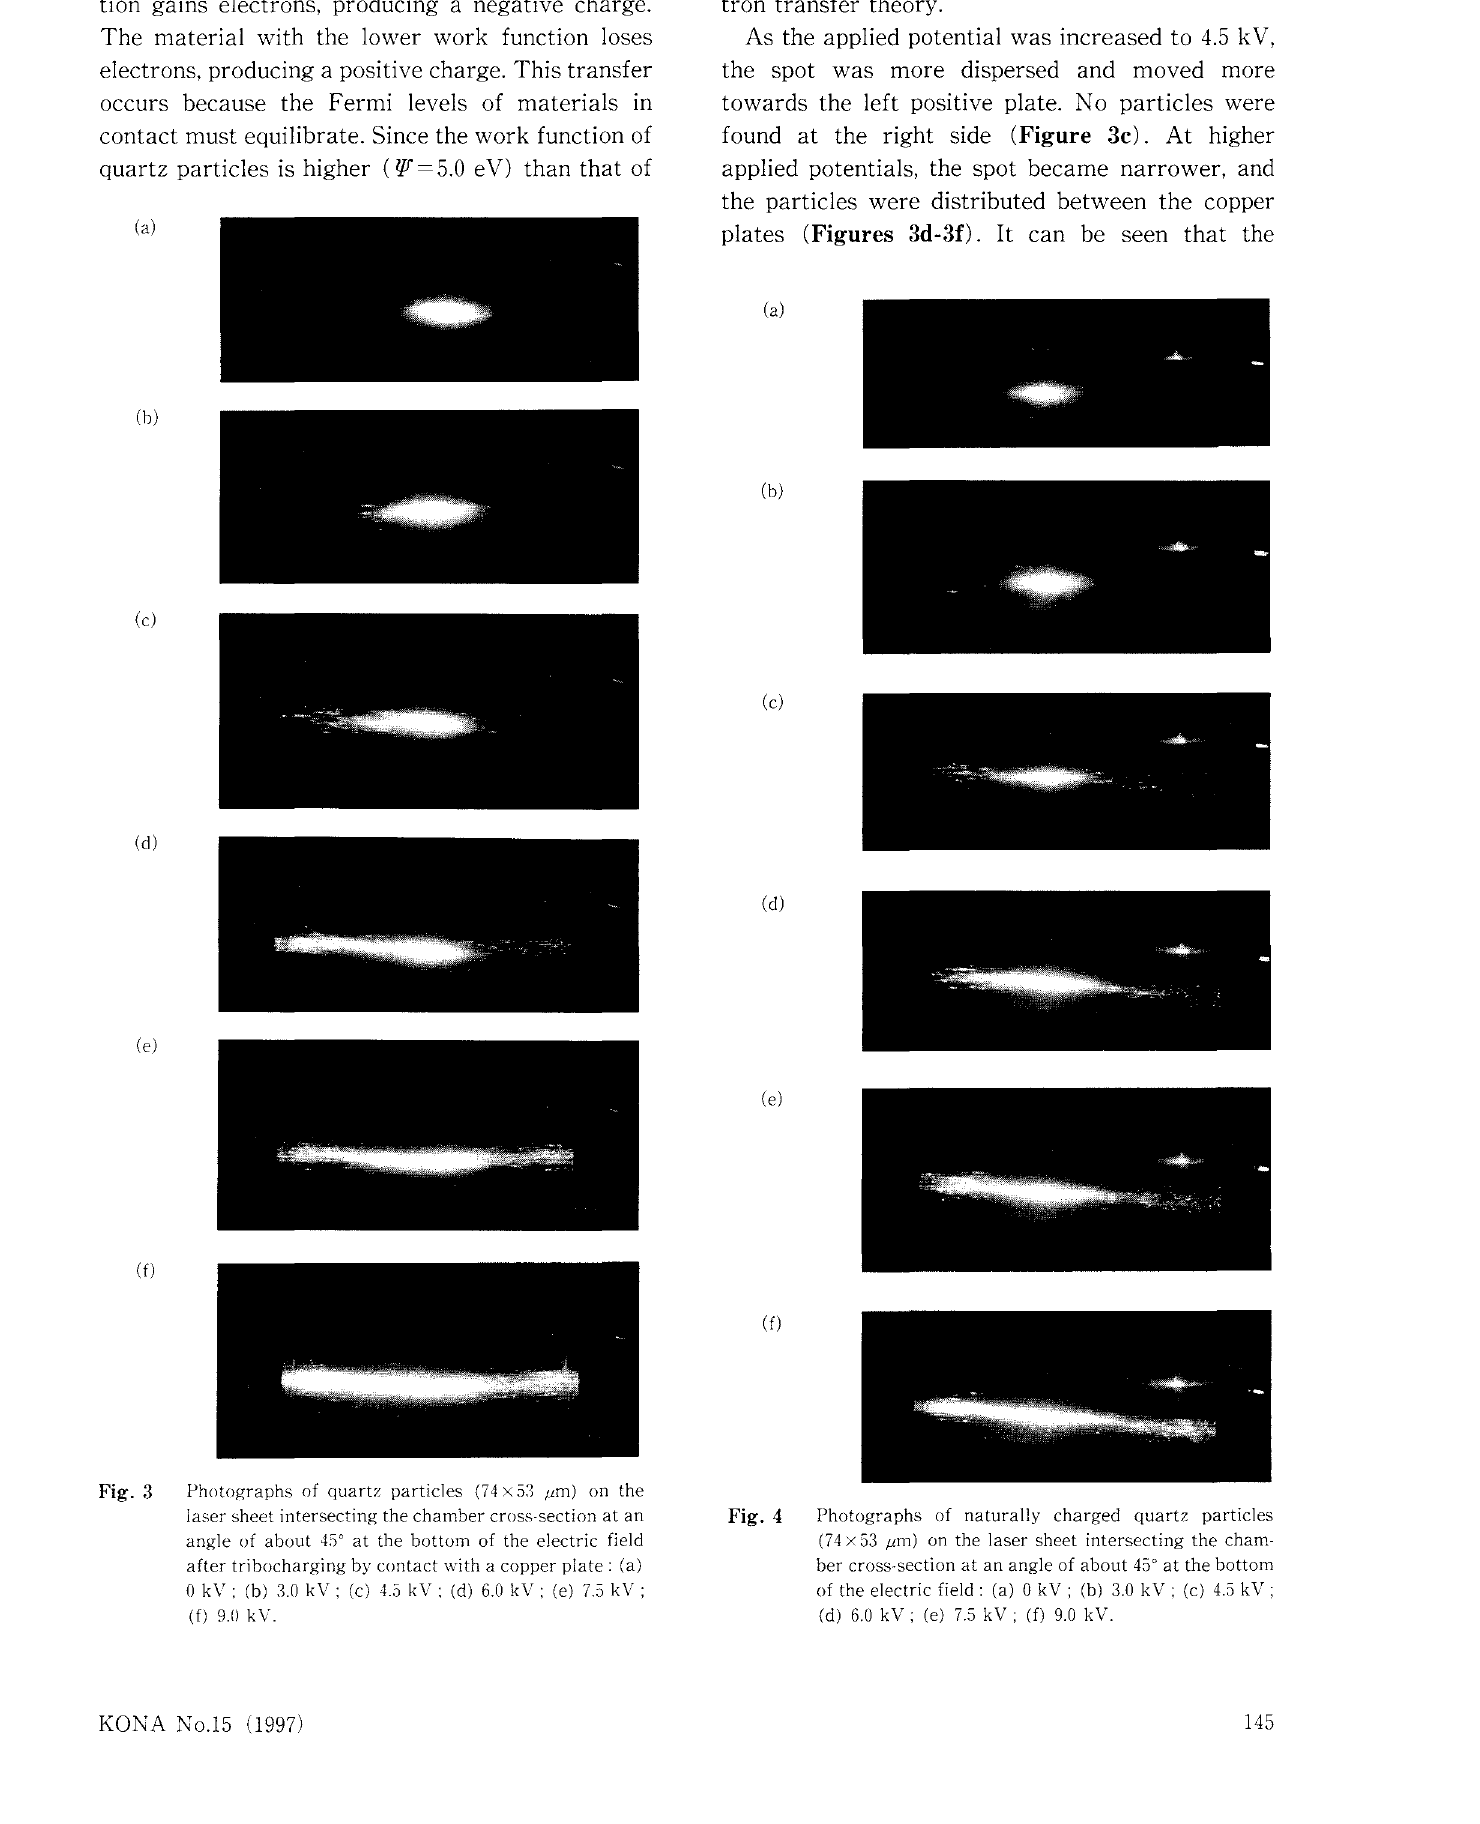
Fig. 4 Photographs of naturally charged quartz particles (7 4 x 53 11m) on the laser sheet intersecting the cham ber cross-section at an angle of about 45° at the bottom of the electric field: (a) 0 kV; (b) 3.0 kV; (c) 4.5 kV; (d) 6.0 kV; (e) 7.5 kV; (f) 9.0